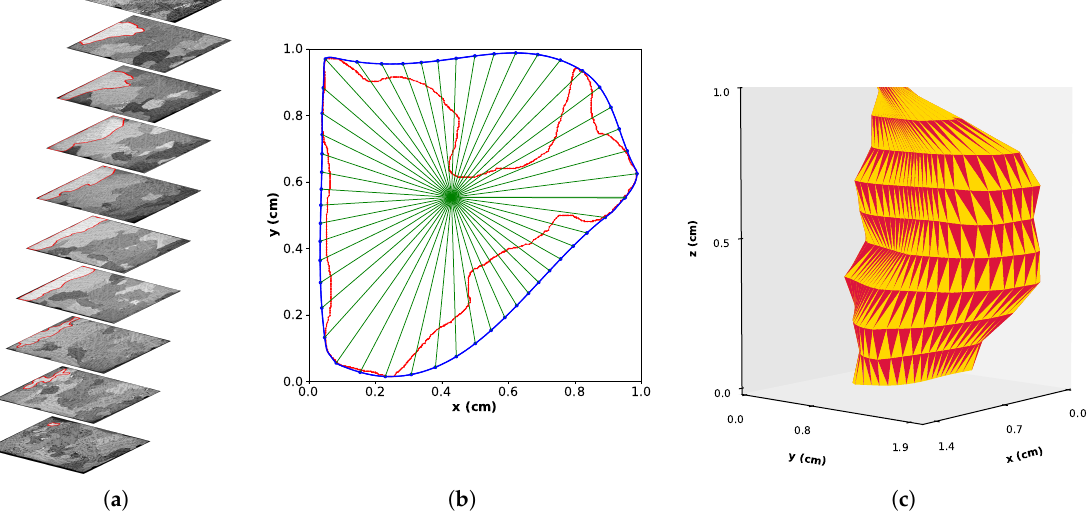
Figure 3. Principle of 3D reconstruction with 2D outlining followed by polar discretization. ( a ) Same grain outlined on each slice. ( b ) Concave contours (red) resulting from the 2D outlining in one slice of ( a ) with its convex Hull contour (blue). Green lines shows the polar discretization of the blue contour. ( c ) 3D reconstructed equiaxed grain. This the same grain as in ( a ). This grain is also colored in light grey at the bottom of each slice in Figure